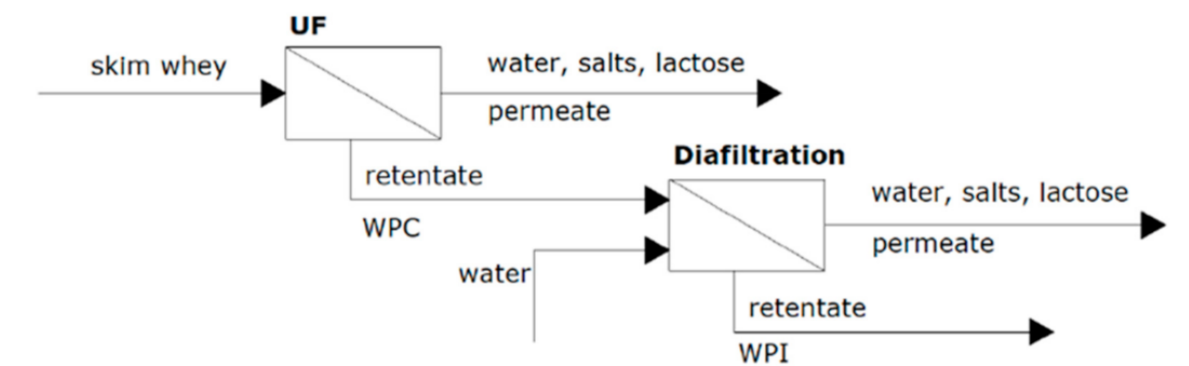
Figure 7. WPC and WPI production by UF and diafiltration from skim whey.